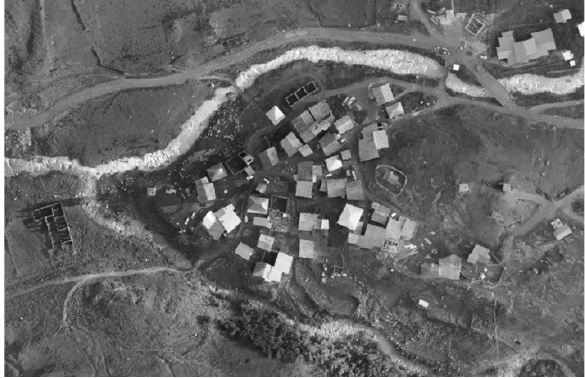
Figure 2. Point cloud model of Chazhashi, Upper Svaneti, after drone survey, Ci-ESG,